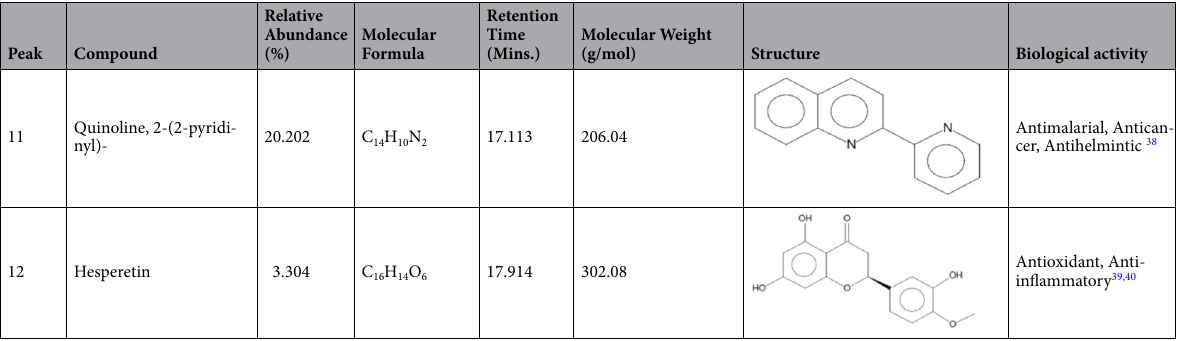
Table 5. Bioactive compounds identified in P. guineense